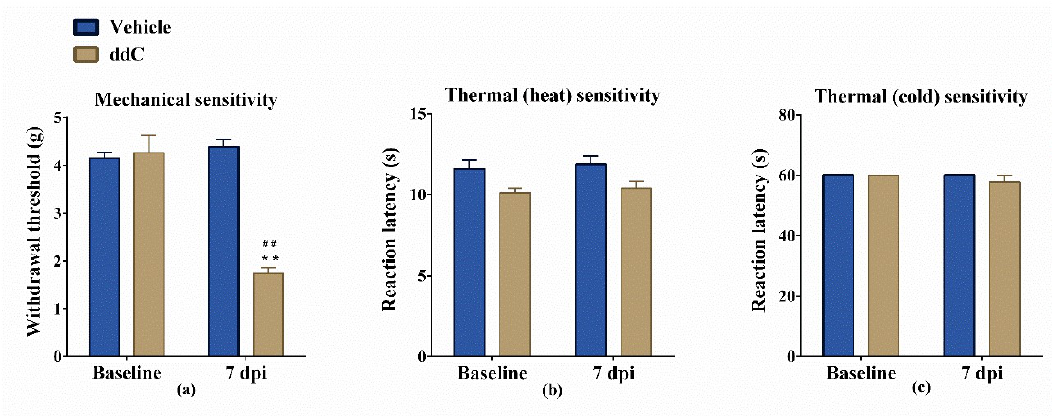
Figure 1. Effects of 2′-3′-dideoxycytidine (ddC) on sensitivity of female BALB/c mice to mechanical and thermal (hot and cold) stimuli. ( a ) Withdrawal threshold to the dynamic plantar aesthesiometer before (baseline) and at day 7 post-first-injection (7 dpi) of ddC. ( b ) Reaction latency to the hot plate (55 °C) before and at 7 dpi of ddC. ( c ) Reaction latency to the cold plate (4 °C) before and at 7 dpi of ddC. Each bar represents the mean ± SEM of values obtained from eight animals. ** p < 0.01 compared to vehicle-treated control mice at the same day after treatment (two-way repeated measures ANOVA followed by Sidak’s multiple comparisons test); ## p < 0.01 compared to pretreatment baseline values (Mann–Whitney test).